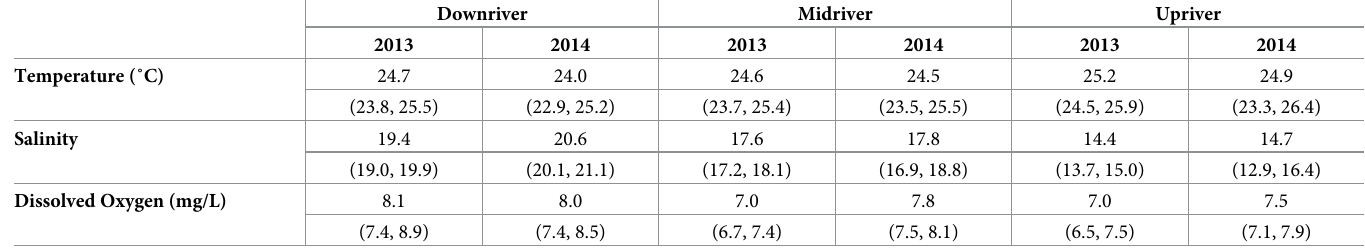
Table 1. Summary of environmental data collected at sampled sites, including means of each variable during each sampling year; 95% confidence intervals are in